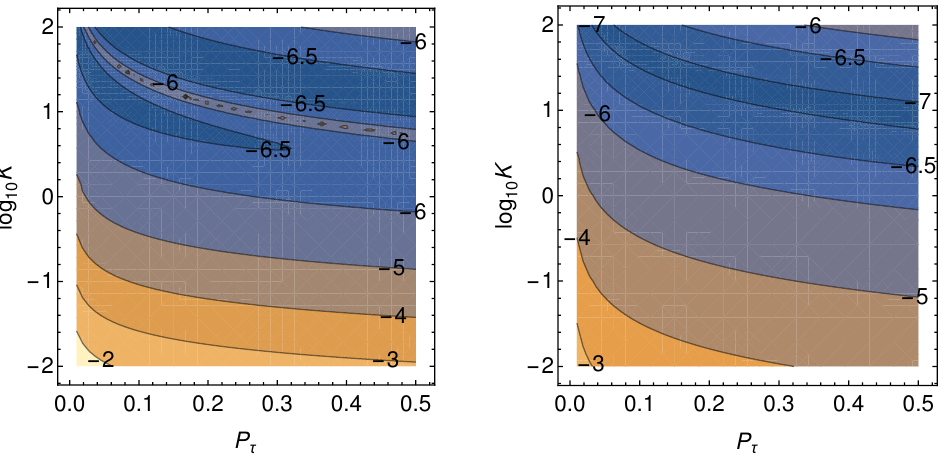
Figure 5 . Required log ( (cid:31) j (cid:15) (cid:28) j ) with large CP (cid:22)(cid:28) breaking of (cid:31) = 0 : 8 (in log scale) to explain the 10 observed baryon asymmetry with zero (left) and thermal (right) initial N 1